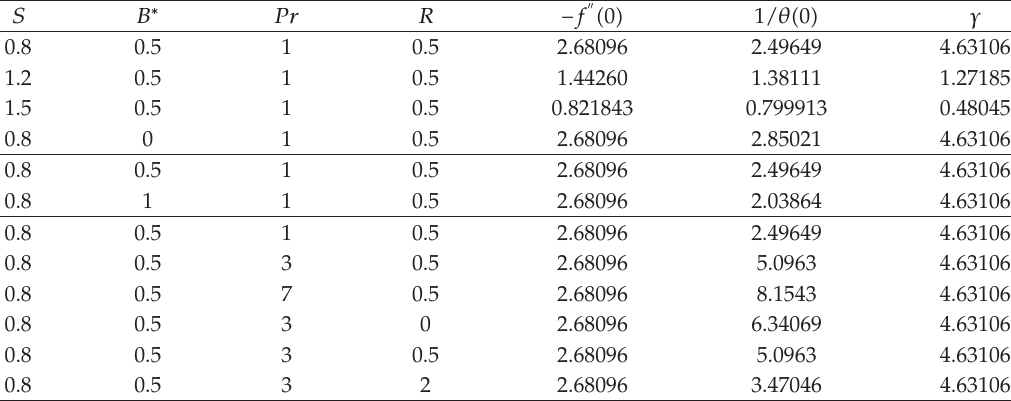
Table 2: Values for − f (cid:5)(cid:5) (cid:3) 0 (cid:4) , 1 /θ (cid:3) 0 (cid:4) and γ for di ff erent values of S, B ∗ , Pr, and R using